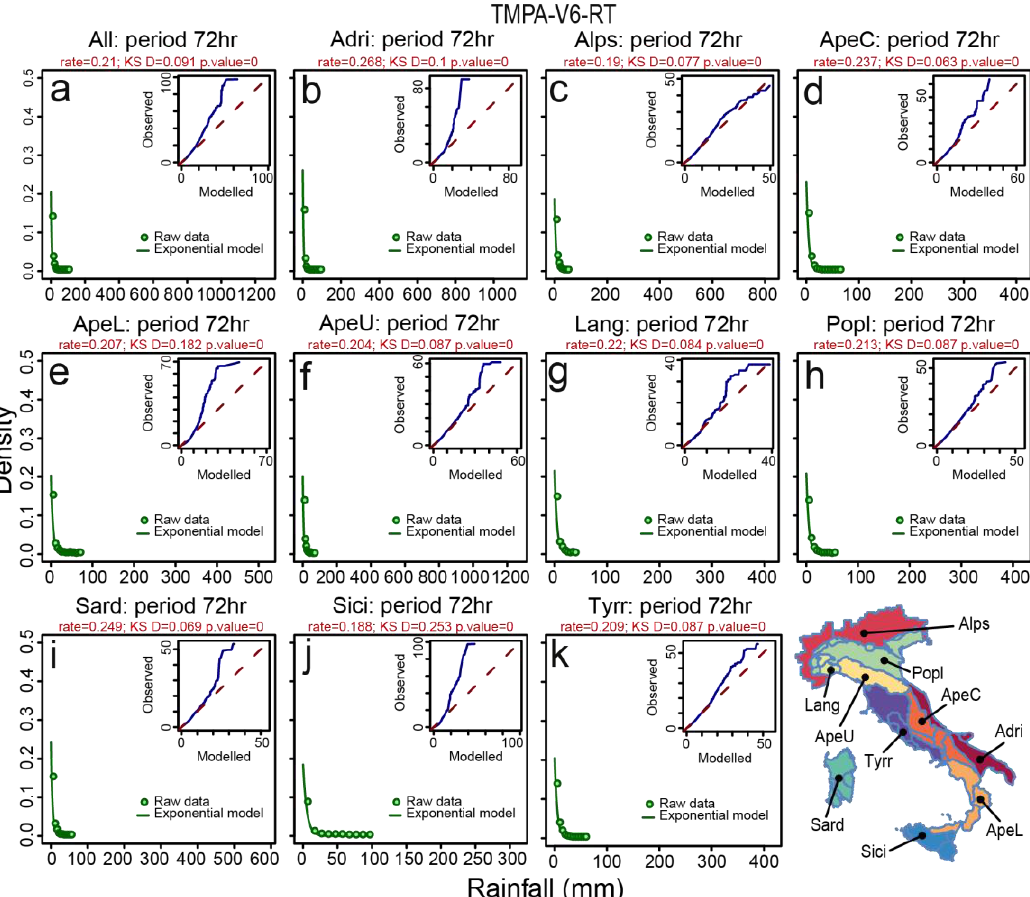
Figure 13. Exponential distribution estimated for 72-h cumulative rainfall using the MLE method satellite estimates (TMPA-V6-RT). The different plots show results for different Italian morphological subdivisions: ( a ) entire Italian territory; ( b ) Adri; ( c ) Alps; ( d ) ApeC; ( e ) ApeL; ( f ) ApeU; ( g ) Lang; ( h ) Popl; ( i ) Sard; ( j ) Sici; ( k ) Tyrr. The insets show QQ-plot measuring the fitting performance of the exponential model. KS D and p -value are two-sided bootstrapped Kolmogorov-Smirnov test statistics (see Table 6).